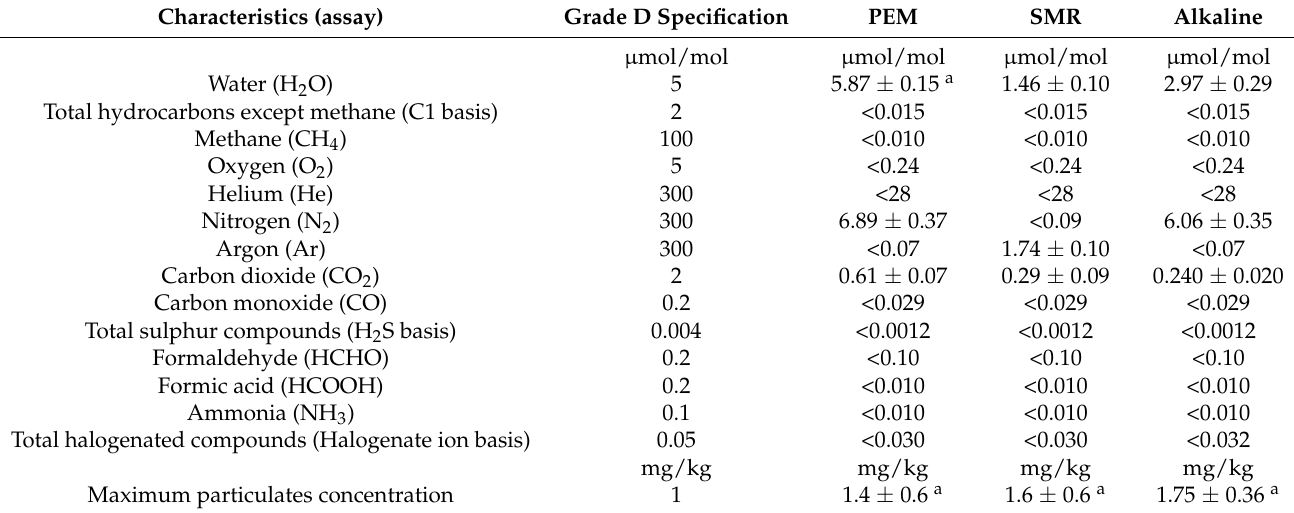
Table 2. Analysis of ISO 14687 contaminants found in hydrogen production